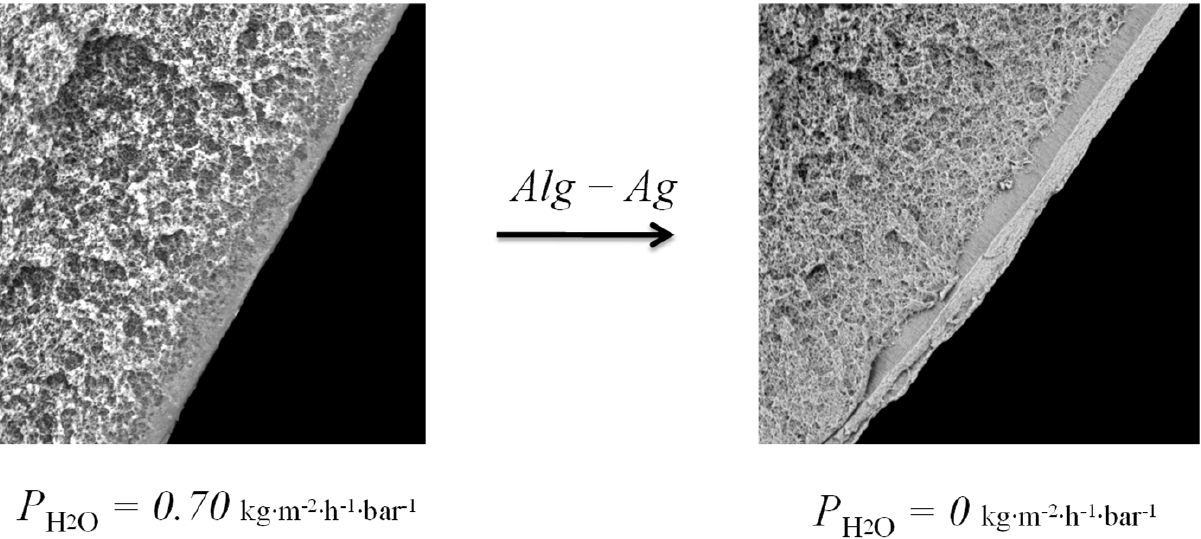
Figure 11. Effect of a selective layer of silver alginate on water flux.